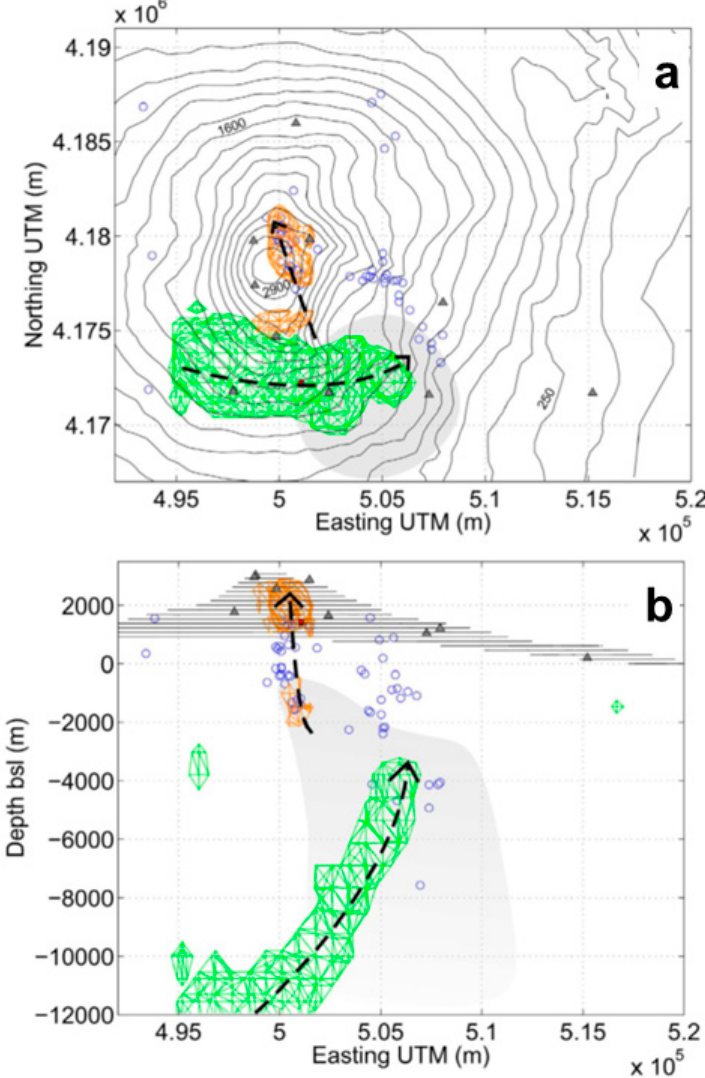
Figure 16. Planar view ( a ) and EW vertical cut view ( b ) of the main elements from the real time modelling process covering the inflation period and the eruption on 13 May 2008, and possible connections between the source bodies and the location of the earthquakes (blue circles) for 12–14 May 2008. Contours correspond to surface topography. Gray triangles indicate the location of the GPS stations. Shaded gray area outlines the position of the High Velocity Body (HVB) [100]. In green, the cumulated sources during the yearlong recharging phase and in orange the sources active during the day of the eruption. Cannav ò et al. [17] suggested fast magma ascent from the reservoir level (2–3 km depth bsl) along paths indicated by the source geometries and the earthquake locations (dashed lines in the figures)